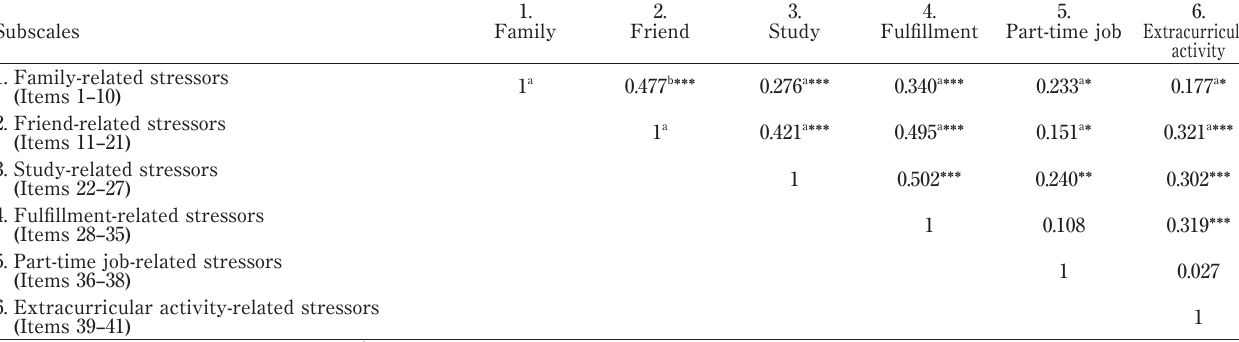
Table 3. Spearman correlation coefficients among the Modified Stressor Scale for College Student (M-SSCS) subscales (n = 198)